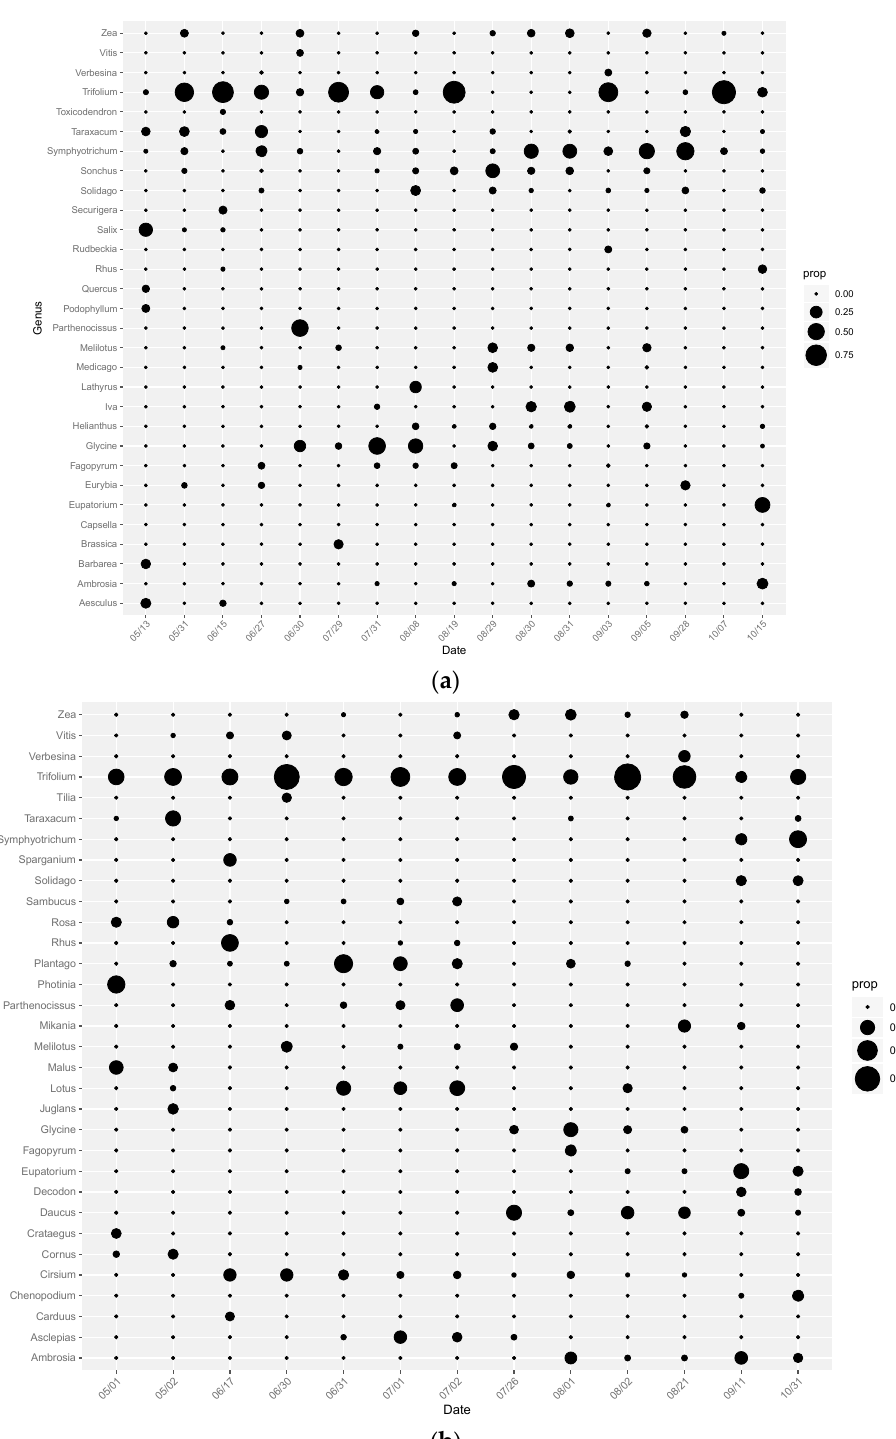
Figure 1. Proportional abundance of pollen samples using pollen metabarcoding analysis. Circle size indicates proportional abundance of a given taxa on a given sampling date. ( a ) In 2016, key genera detected were Trifolium (clovers), Symphyotrichum (American asters), and Glycine (soybeans). ( b ) In 2017, Trifolium was a key genus detected; however, a diverse array of additional taxa were detected in moderate abundances.